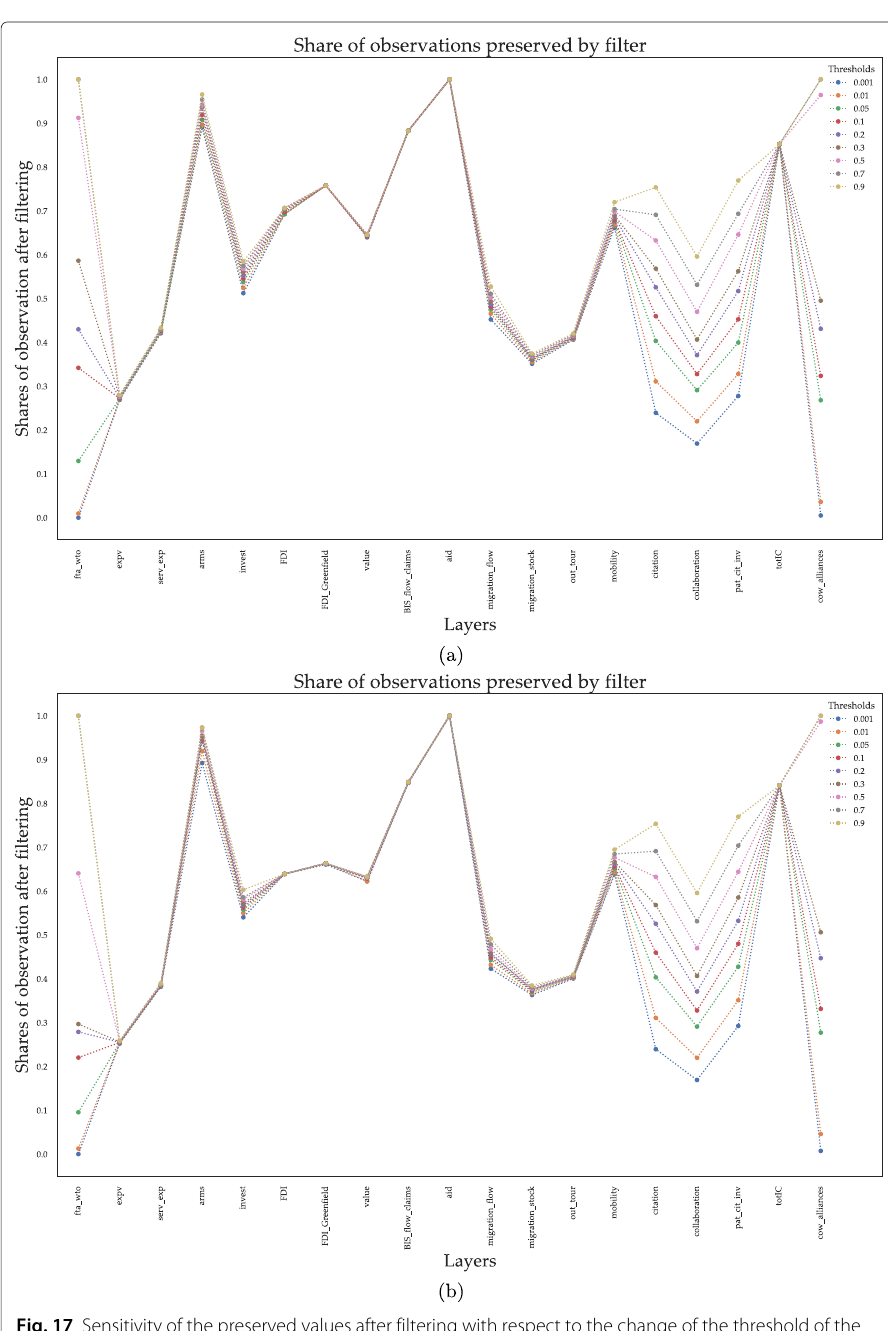
MultiRank which are not heavily affected by the choice of γ in at least the majority of the range of its